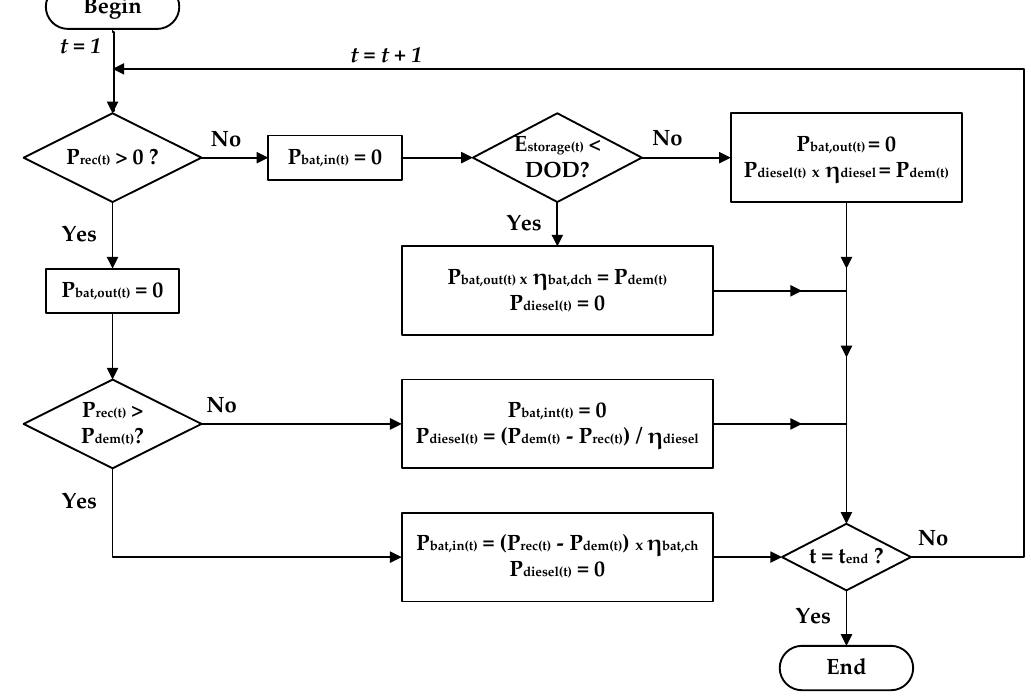
Figure 3. Flowchart to calculate the power involved in the process, every second.